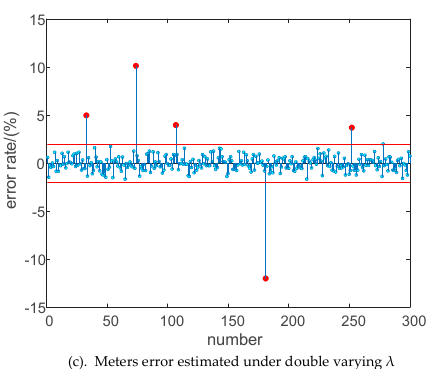
Figure 6. Result of operational error of 300 meters under different states of λ .